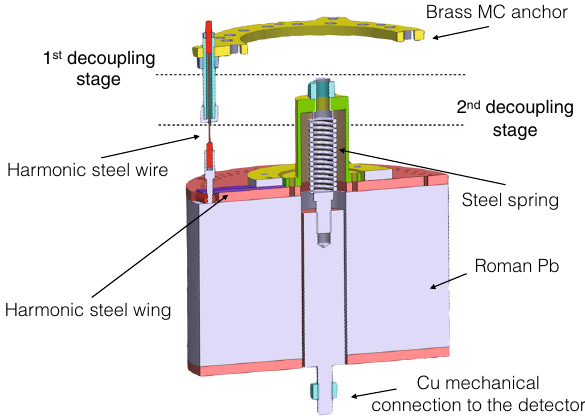
Fig. 18 Rendering of the double stage mechanical decoupling system. This is installed directly on the cryostat mixing chamber with the top brassanchorandonthebottompartthereisaCumechanicalconnection for the detector